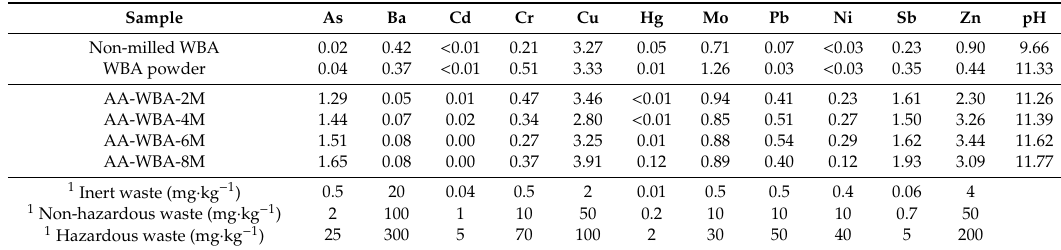
Table 5. Leaching concentrations (mg · kg − 1 ) on WBA and AA-WBA binders after leaching tests (EN 12457-2) and limits for acceptance at landfills .